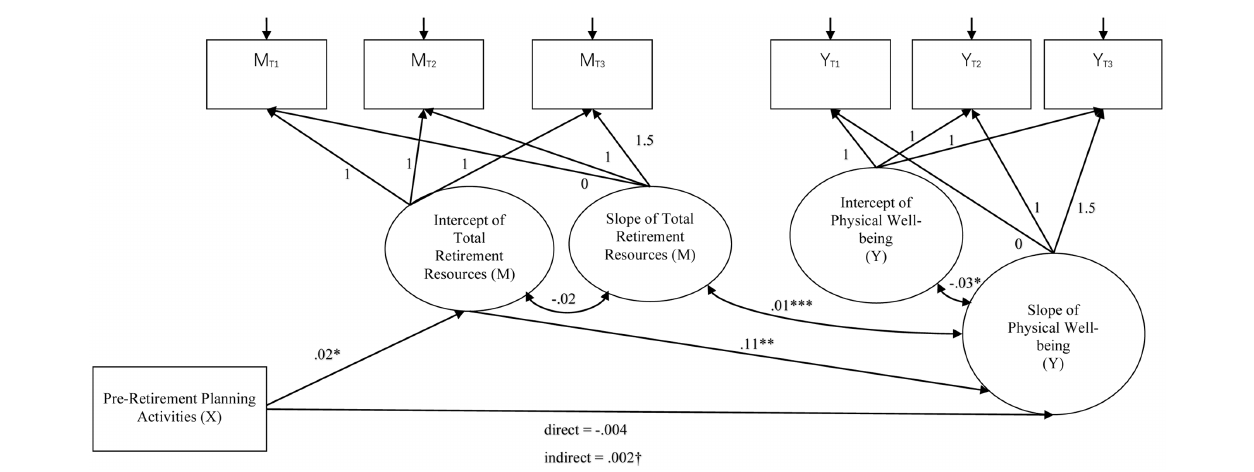
FIGURE 2 | The latent growth mediation model on physical well-being. X denotes the independent variable; M denotes the mediator; and Y denotes the dependent variable. The model fit indices are: CFI = 0.972; RMSEA = 0.083; AIC = 98.075; BIC = 167.342. Age and gender were controlled in the model as covariates.